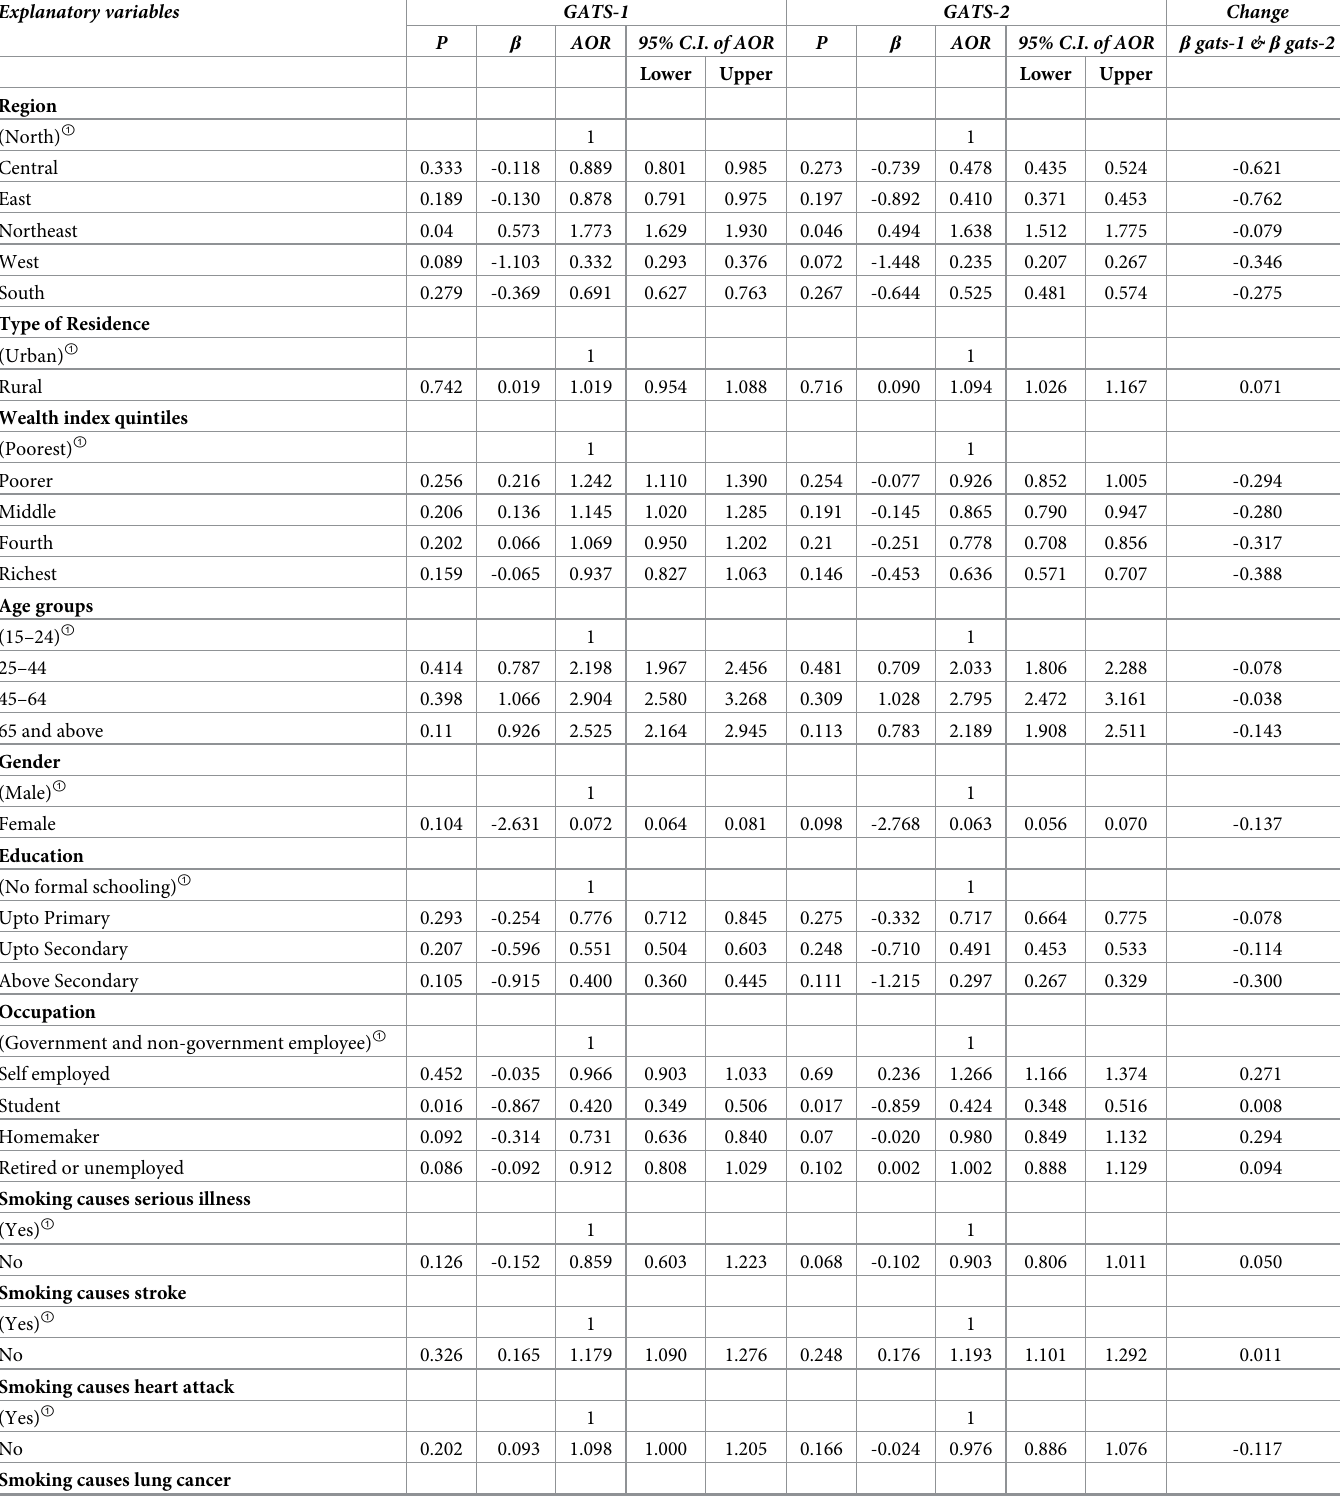
Table 2. Multivariable binary logistic regression for smokers in India, GATS-2009-10 and GATS-16-17. Explanatory